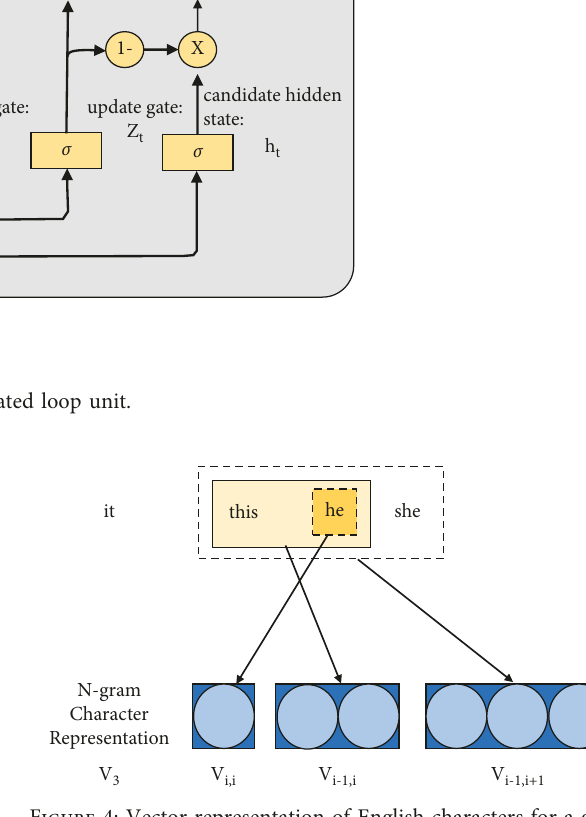
Figure 4: Vector representation of English characters for a given